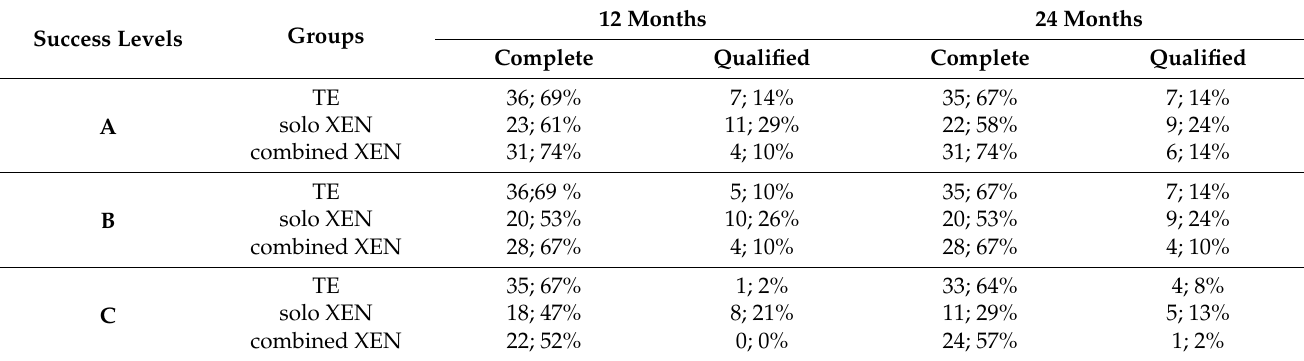
Figure 2. Development of visual acuity in the three treatment groups during the 24 months of follow-up. Table 3. Percentages of success levels achieved by eyes in the three different treatment groups 12 and 24 months after surgery. A: success level A (IOP < 21 mmHg ± medication); B: success level B (IOP < 18 mmHg ± medication); C: success level C (IOP < 15 mmHg ±